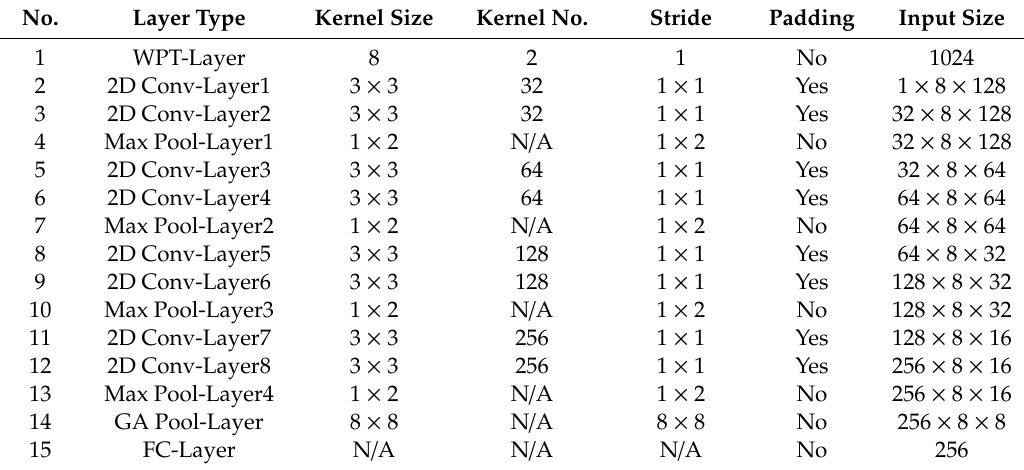
Table 4. Detailed parameters of the proposed WPT-CNN.